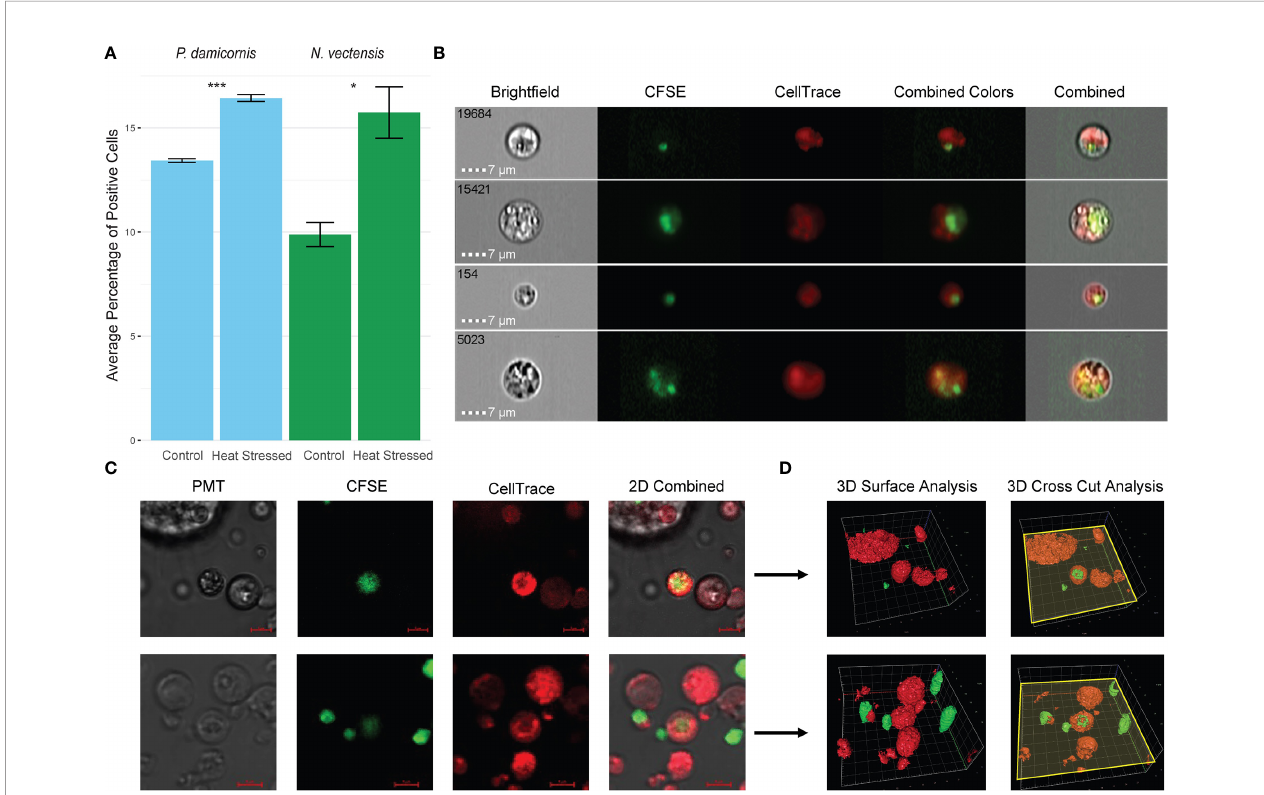
FIGURE 3 | Phagocytosis in P. damicornis and N. vectensis of damaged cells. (A) Percentage of cells in P. damicornis (blue bars) and N. vectensis (green bars) that engulfed cells. Cells from different animals were differentially labeled (CellTrace and CFSE), to detect double positive events that would indicate engulfment of cells. The control group was exposed to cells kept at ambient conditions, while the heat stress group (both labeled with CFSE) was exposed to cells that were kept at 42°C for one hour. Each test treatment is signi fi cantly different from the control treatment. (B) Inserts of ImageStream analysis of N. vectensis cells stained with CellTrace (red) and cells stained with CFSE (green) that were heat stressed. The images are examples of the gated double positive population for validation of cells, or their particles engulfed by the red cells. Scale bar 7 m m. (C) Example of 2D images slides in confocal microscopy of N. vectensis cells stained with CellTrace (red) and cells stained with CFSE (green) that were heat stressed. For validation at least 40 slices were taken on a Z axis to create 3D surface analysis (in D ). Scale bars 5 m m. (D) Inserts of 3D surface analysis to show the full cells (right panels), of the examples in (C) The yellow plane depicts the cross section done in the Z-axis (right panels), and surface analysis of the parts below the plane to show what is inside the cells. In the center of the image CFSE labeled cells can be seen engulfed by CellTrace labeled cells. Grid scales for the upper panel are 4 m m, and 3 m m for the lower panel. P-value marks: *p < 0.05, ***p <